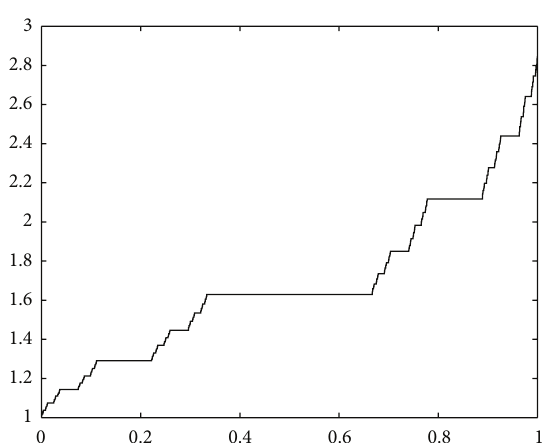
Figure 3: Another Cantor-like function defined on the same Cantor